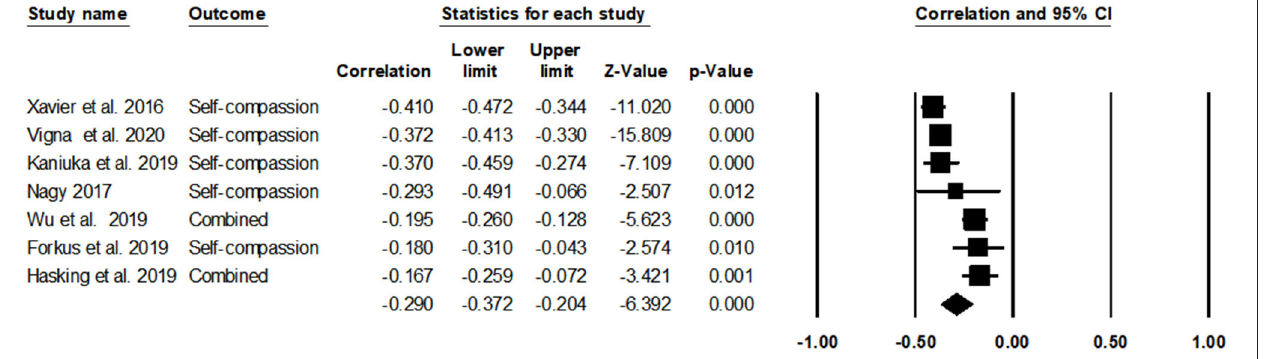
FIGURE 3 | The association of self-compassion with non-suicidal self-injury